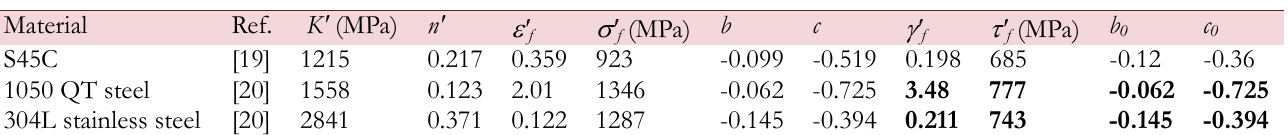
Table 2: Fatigue properties of the investigated materials